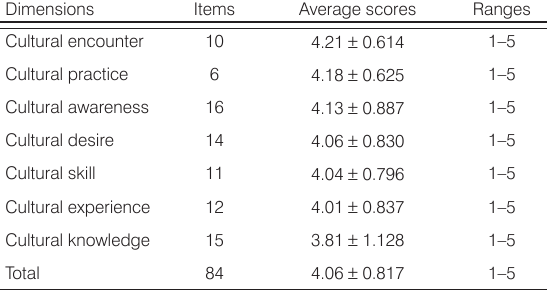
Table 1. Cultural competence scores among registered nurses (M ±